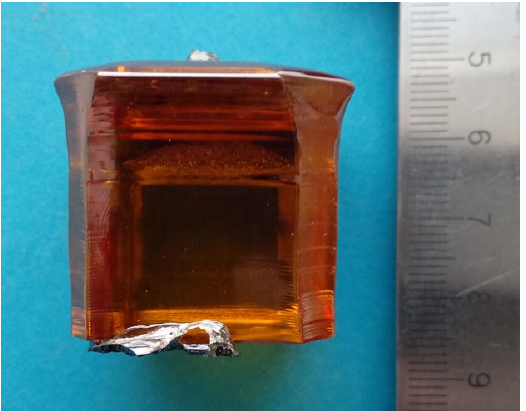
Figure 2. Bi 12 GeO 20 (BGO) crystal doped with 0.3 mol.% Eu 3+ .